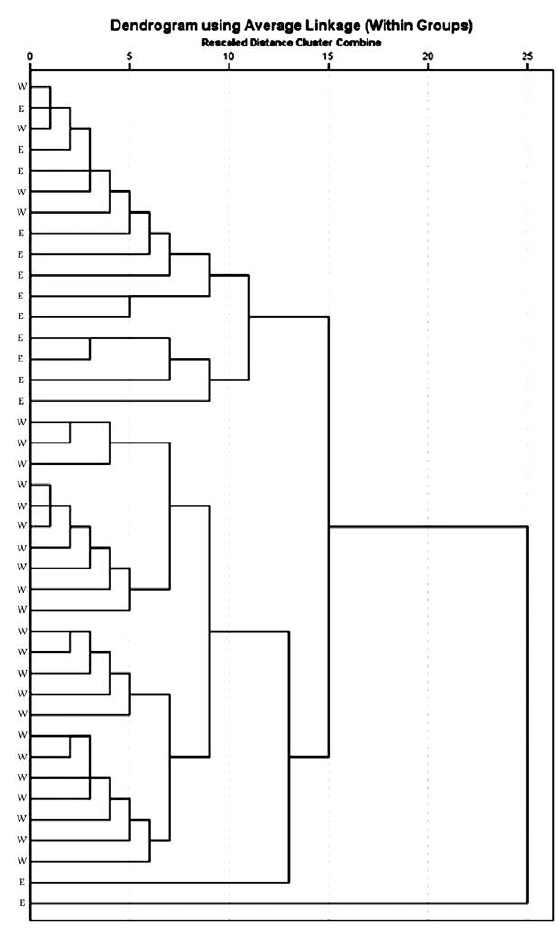
Fig. 4. – Landmark-based method dendrogram derived from cluster analysis showing the relationships between body shape of juvenile Persian sturgeon in two regions. E represents eastern part individual body shape and W represents western part individual body